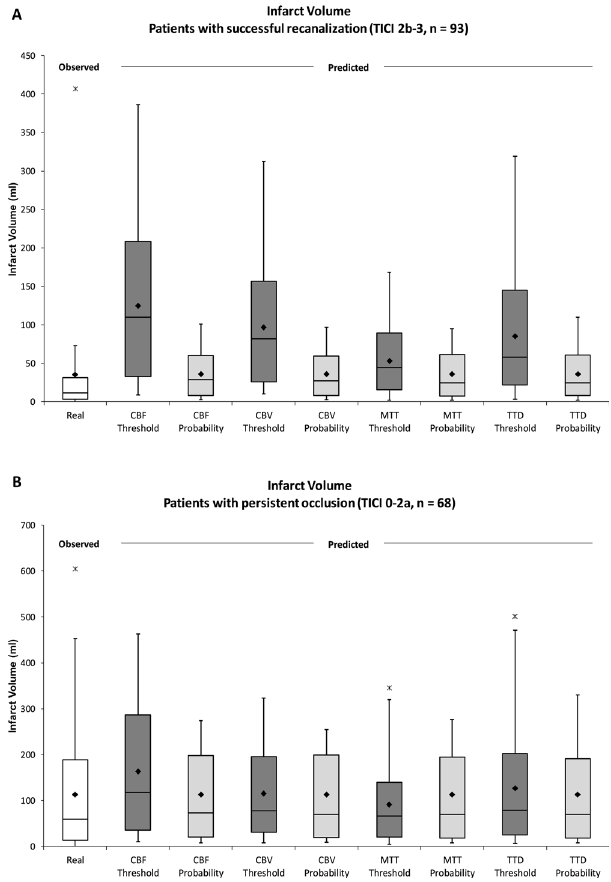
Figure 2. Real and predicted infarct volume for ( A ) 93 patients with successful recanalization (TICI 2b-3) and ( B ) 68 patients with persistent occlusion (TICI 0-2a). The real infarct volume and the predicted infarct volumes based on CBF, CBV, MTT, and time to drain (TTD) parameter map using the thresholding method and the probabilistic threshold-free method are shown. While the mean predicted infarct volume in the conventional threshold group does not necessarily correspond to the mean real volume, the mean predicted infarct volume predicted by the probability model fits the real mean infarct volume. ♦ = mean, horizontal line = median, x =